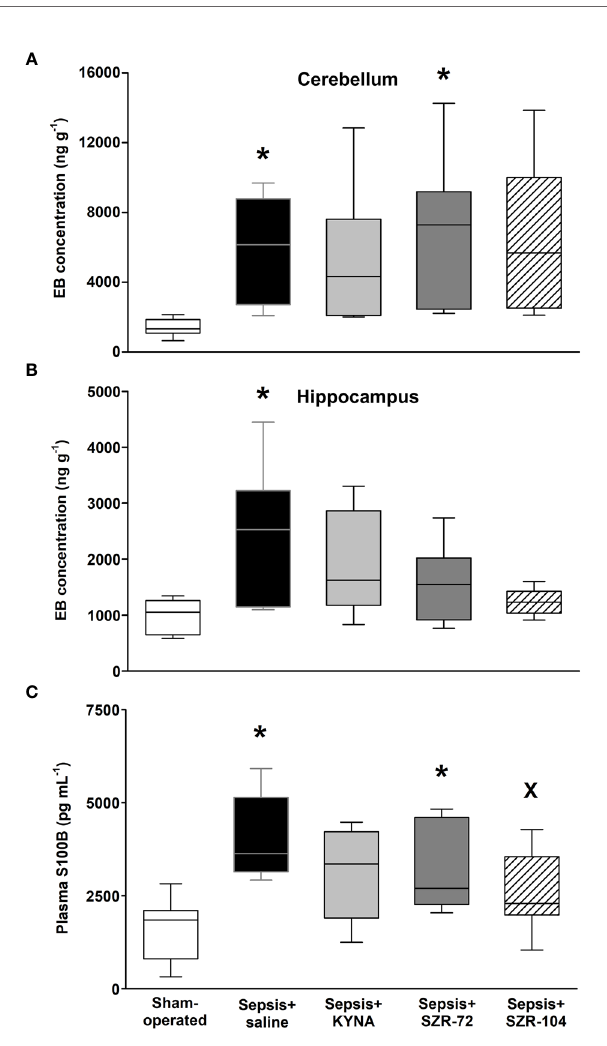
FIGURE 3 | Blood – brain barrier permeability detected by the tissue levels of Evans Blue (EB) in the cerebellum (A) and hippocampus (B) and changes in plasma S100B levels (C) in a sham-operated group and in different sepsis groups treated with saline, KYNA, SZR-72 and SZR-104. The plots demonstrate the median (horizontal line in the box) and the 25 th (lower whisker) and 75 th (upper whisker) percentiles. Kruskal – Wallis test, Dunn ’ s post-hoc test; * P < 0.05 vs . sham-operated group; x P < 0.05 vs . sepsis+saline